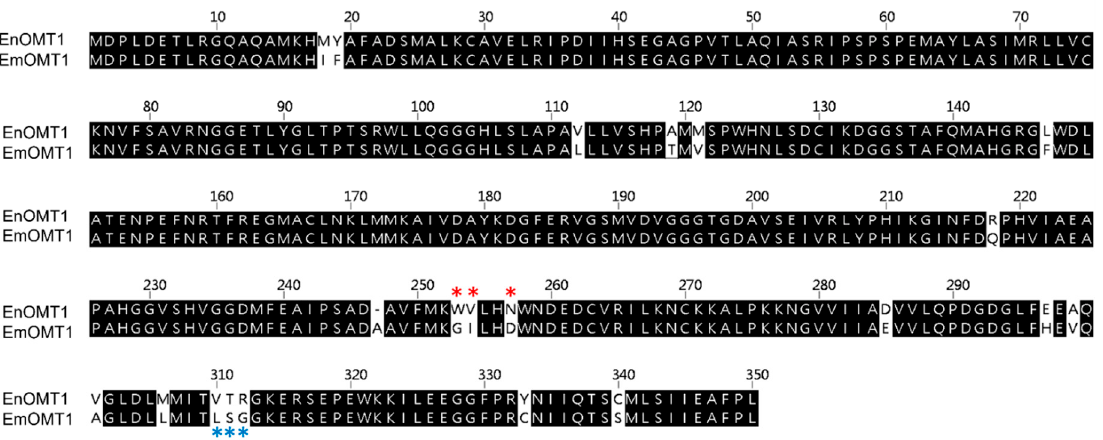
Figure 6. Amino acid alignment of OMT1 sequence from E. nitida (EnOMT1) and E. mitchelliana (EmOMT1). * Variable amino acids of Region 1 are indicated by red asterisks, while variable amino acids of Region 2 are indicated by blue asterisks.